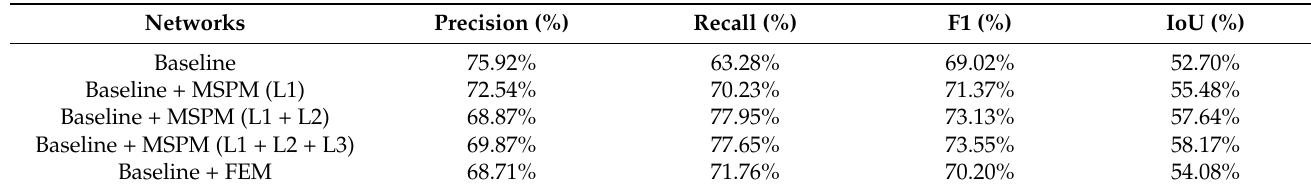
Table 2. Ablation experiments of MSPM and FEM.